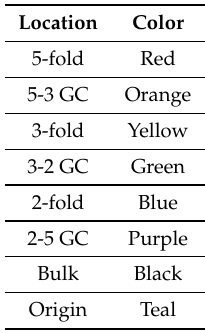
Table 1. The color scheme used for point array elements throughout this paper. Each color specifies the type of geometric location, e.g., 5-fold points are red, 2-fold points are blue, and purple are the points on the great circle between the two (Figure